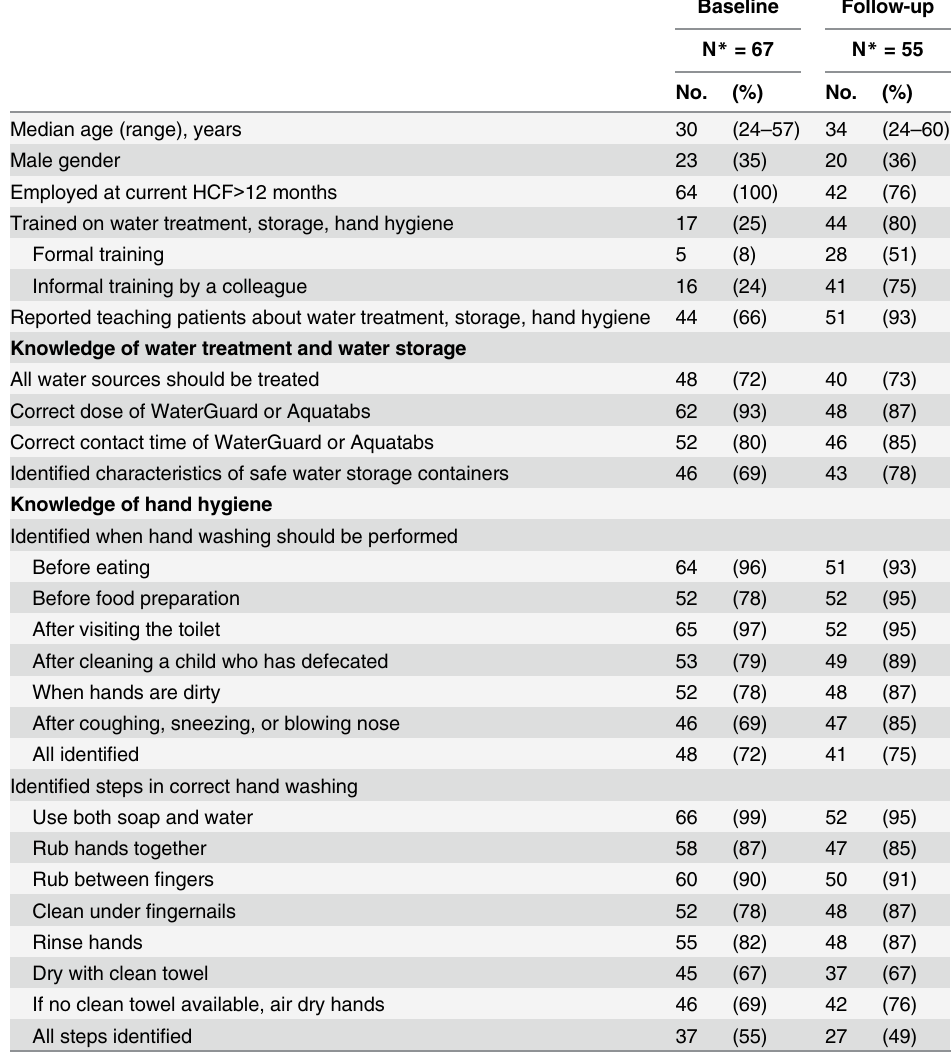
Table 2. Healthcare worker characteristics, training, and patient education practices, and knowledge regarding water treatment, water storage and hygiene principles at baseline and follow-up, western Kenya, 2011 and